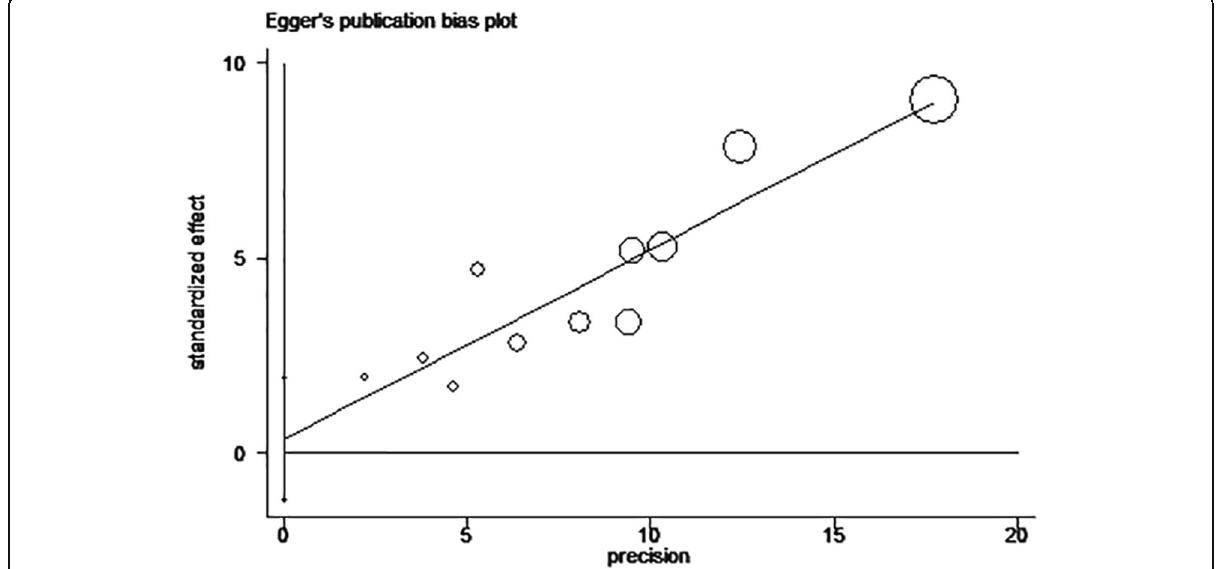
Fig. 8 Egger ’ s test for rs17728338 in TNIP1 gene and risk of